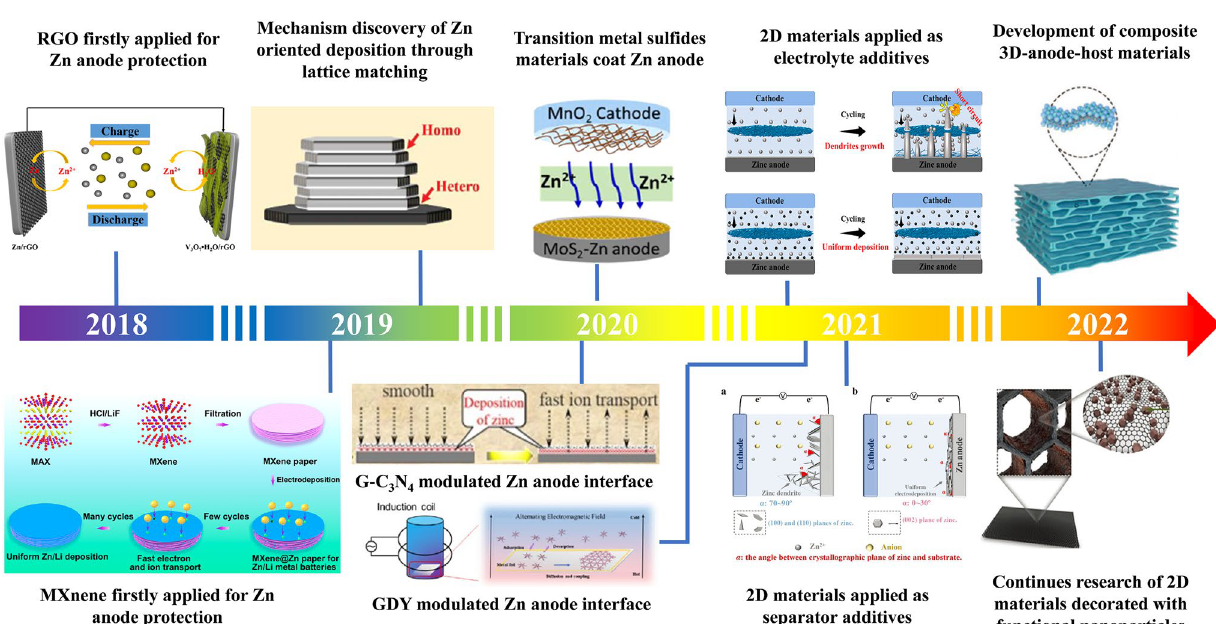
Fig. 3 A brief timeline summarizing the development of 2D materials in Zn anodes of ZIBs. In 2018, Zn firstly coated with 2D material as the anode of ZIBs. Copyright 2018, American Chemical Society. In 2019, mechanisms for 2D materials reinforcing Zn anodes have been deeply researched. Copyright 2019, American Chemical Society; Copyright 2019, American Association for the Advancement of Science. In 2020, other 2D materials starting to be applied in Zn anode protection. Copyright 2020, American Chemical Society; Copyright 2020, Elsevier; Copy- right 2021, IOP. In 2021, 2D materials have been applied as electrolyte additives and separator additives. Copyright 2021, American Chemical Society; copyright 2021, Wiley. In 2022, multi-functional modified 2D materials have been applied as anode-hosts. Copyright 2022,